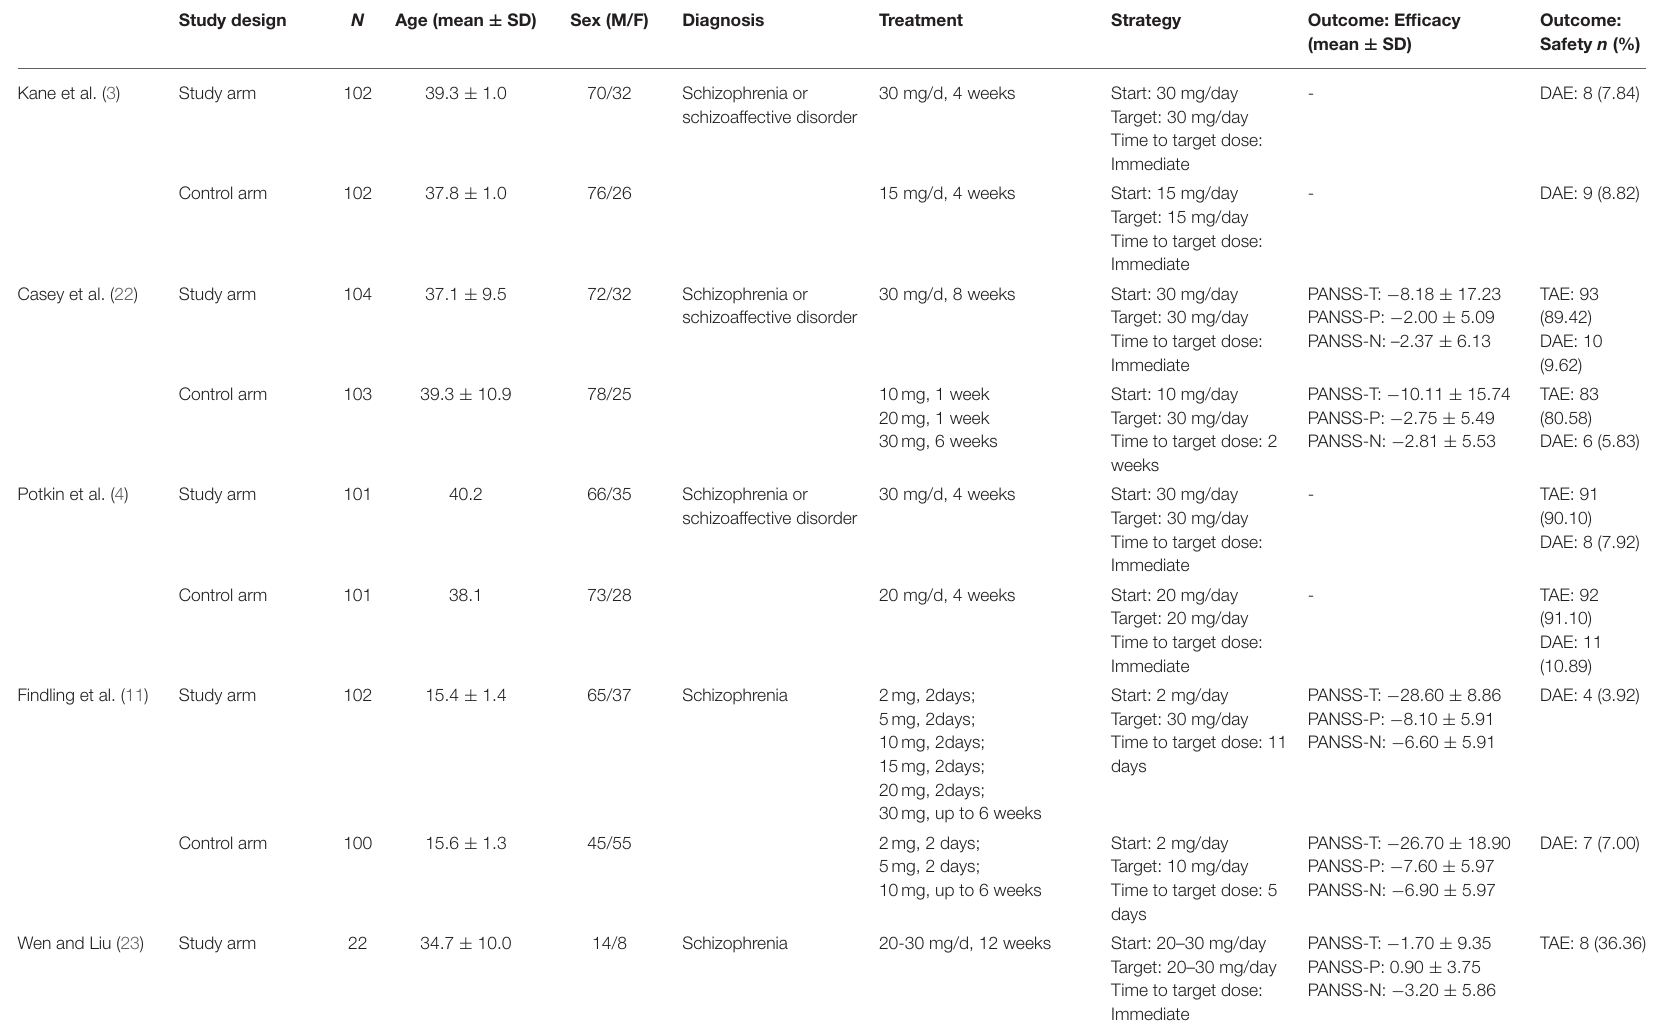
TABLE 1 | Characteristics of randomized controlled